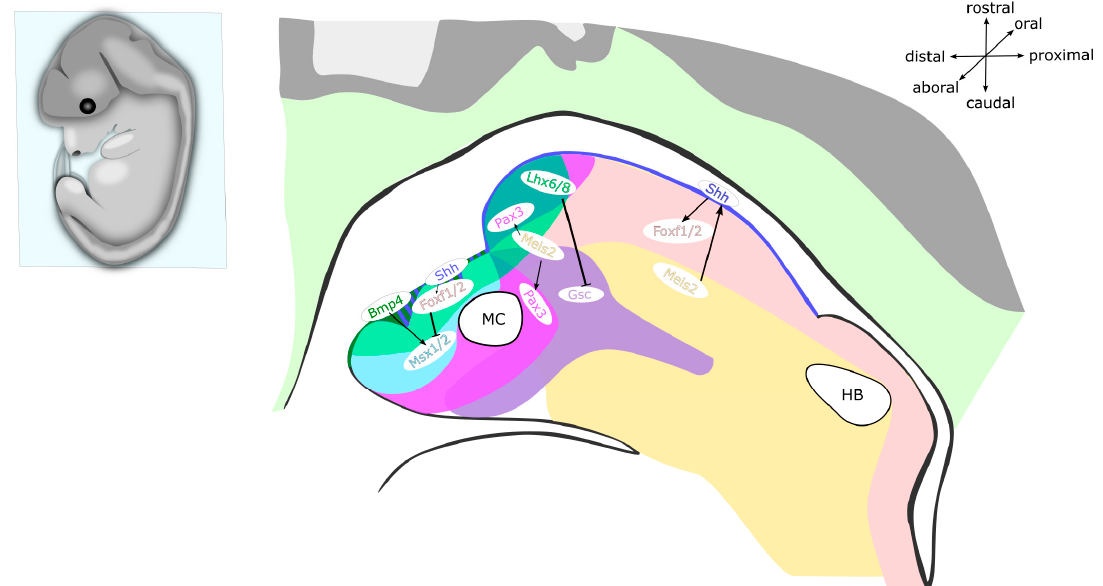
Figure 3. Schematics of a mid-sagittal section through the mandibular and hyoid arches of a mouse embryo at E12. Bmp4 is expressed in the distal mandibular epithelium, at the site of presumptive incisors, while Msx1 is expressed in the distal mandibular ectomesenchyme, surrounding the incisor primordia. Shh is expressed in the vestibular lamina and dental epithelium, as well as in the lingual epithelium, while Foxf1/Foxf2 are expressed in ectomesenchyme in the medial region of the mandibular process, surrounding the incisor primordium and inside the nascent tongue. Pax3 is expressed in the ectomesenchyme of distal tip of the mandibular process and nascent tongue. Lhx6/Lhx8 are expressed in ectomesenchyme on the rostral side, while Gsc is expressed on the caudal side of the mandibular process. Meis2 is expressed in the medial proximal region of the mandibular process and in the medial region of the hyoid arch. Abbreviations: E, embryonic day; MC, Meckel’s cartilage; HB, cartilage primordium of the hyoid bone. Expression domains of genes written in black text are not highlighted in the figure.